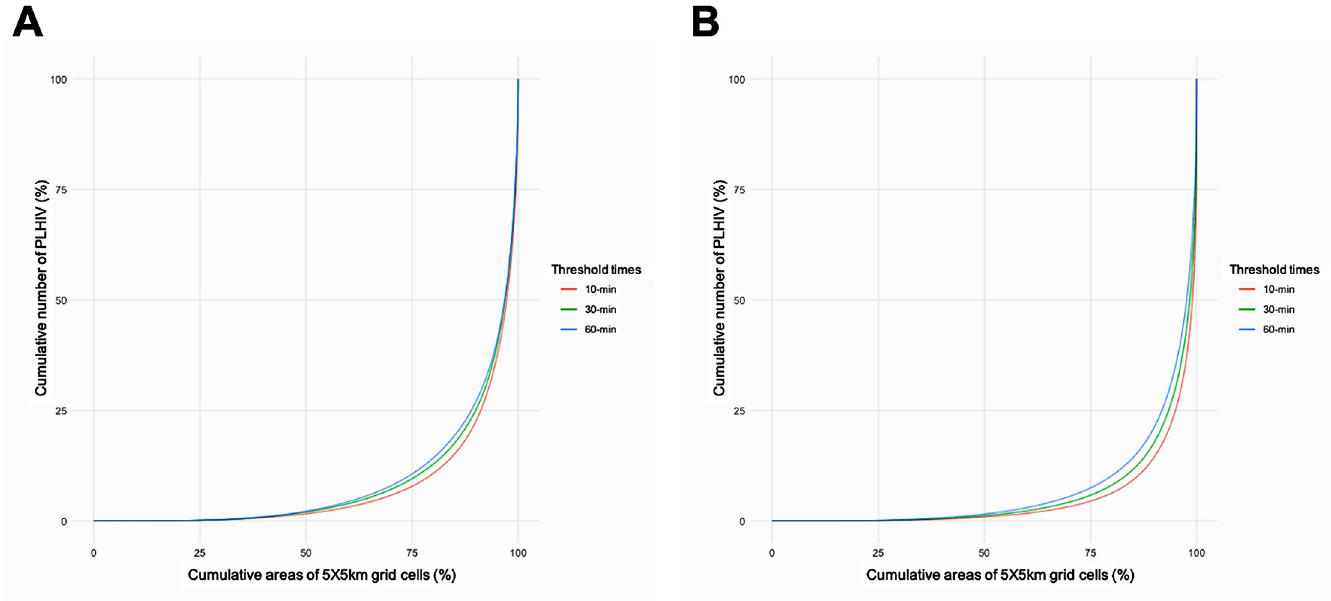
Fig 2. Lorenz curve showing the cumulative percentages of PLHIV compared to the cumulative percentages of 5X5km pixel. Curves showing the cumulative share of PLHIV using motorized (A) and non-motorized (B) transportation in underserved areas by each travel time